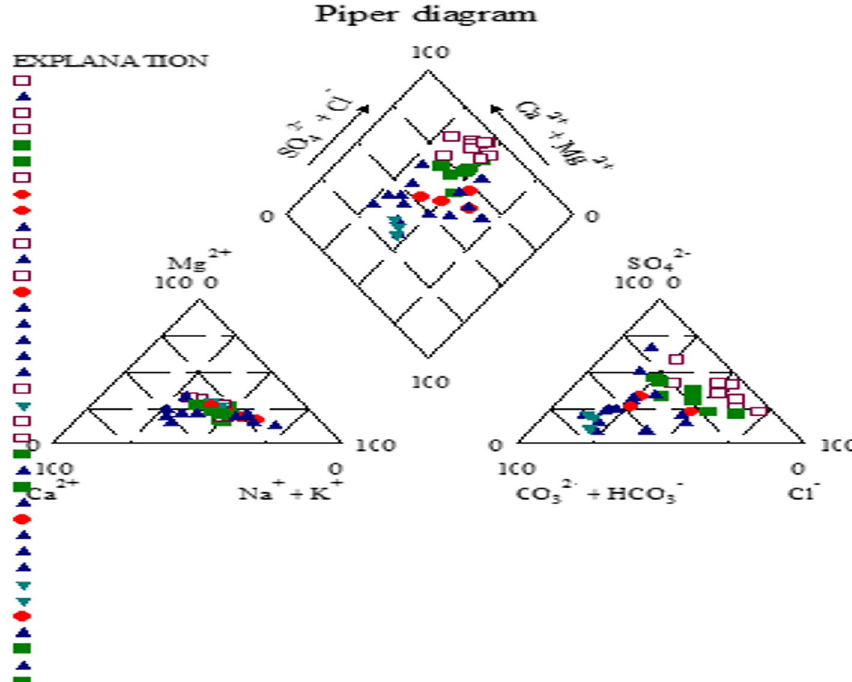
Fig. 2 Piper diagram of the